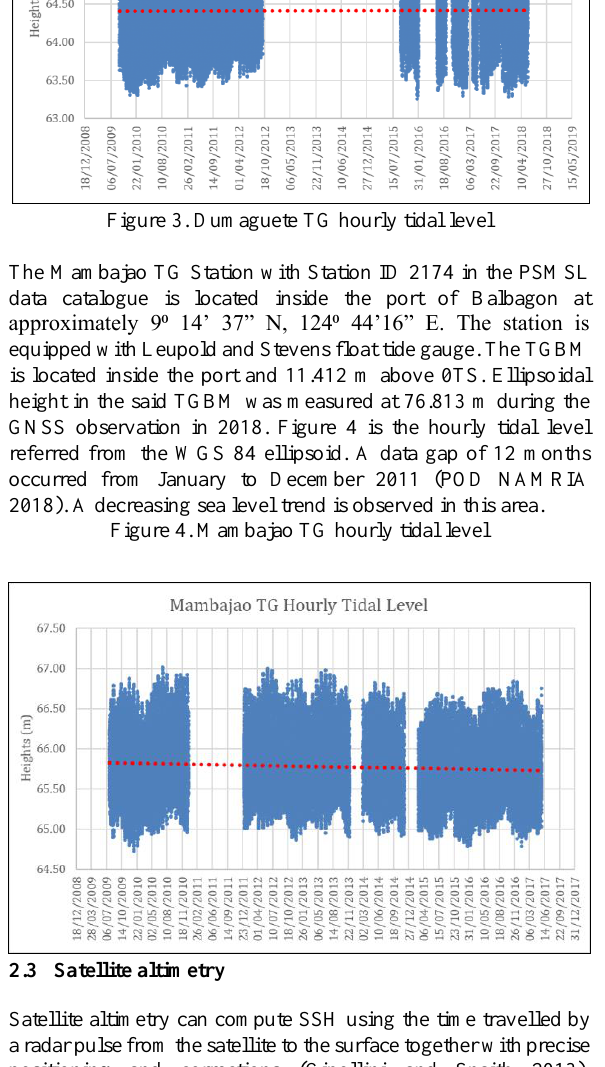
September 2015 (POD NAMRIA 2018). The sea level trend